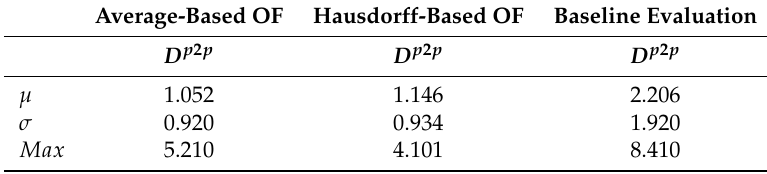
Table 5. Numerical evaluation: Pair-wise distance (in mm) based on the both average and Hausdorff OFs for training set sampled with 65%, and 75%, respectively. Also, the last column denotes the evaluation of dummy